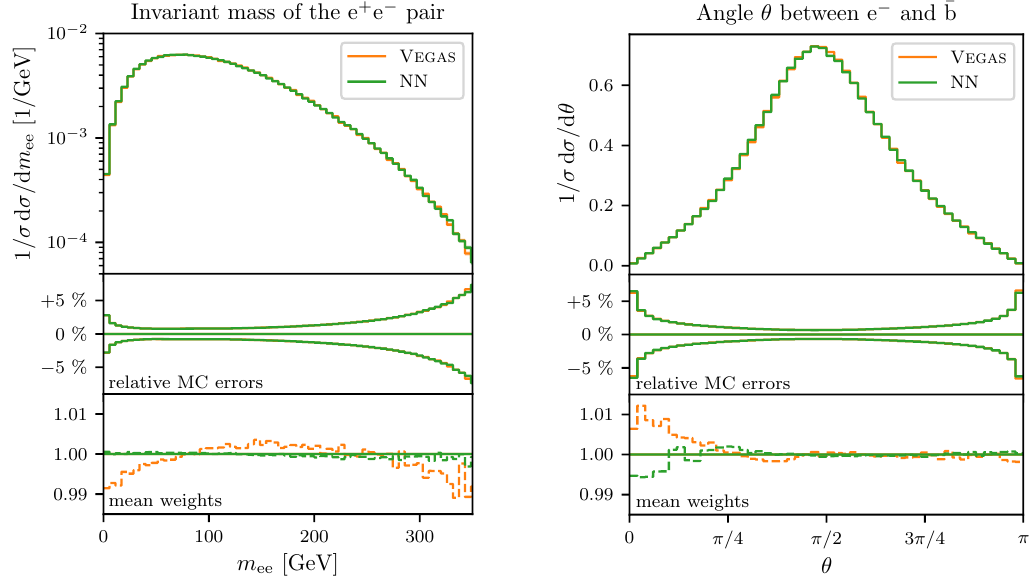
Figure 3: The invariant mass of the electron-positron pair (left) and the angle be- tween the electron and the anti-bottom quark in top-pair production (right). For each observable, we compare the nominal distributions for a V EGAS -optimised and a NN-optimised phase space sampling (upper panes). In the middle panes, Monte Carlo errors for both samples are compared. The lower panes show the mean event weights per bin, highlighting regions of the observables where the sampling distri- butions over- or undershoot the